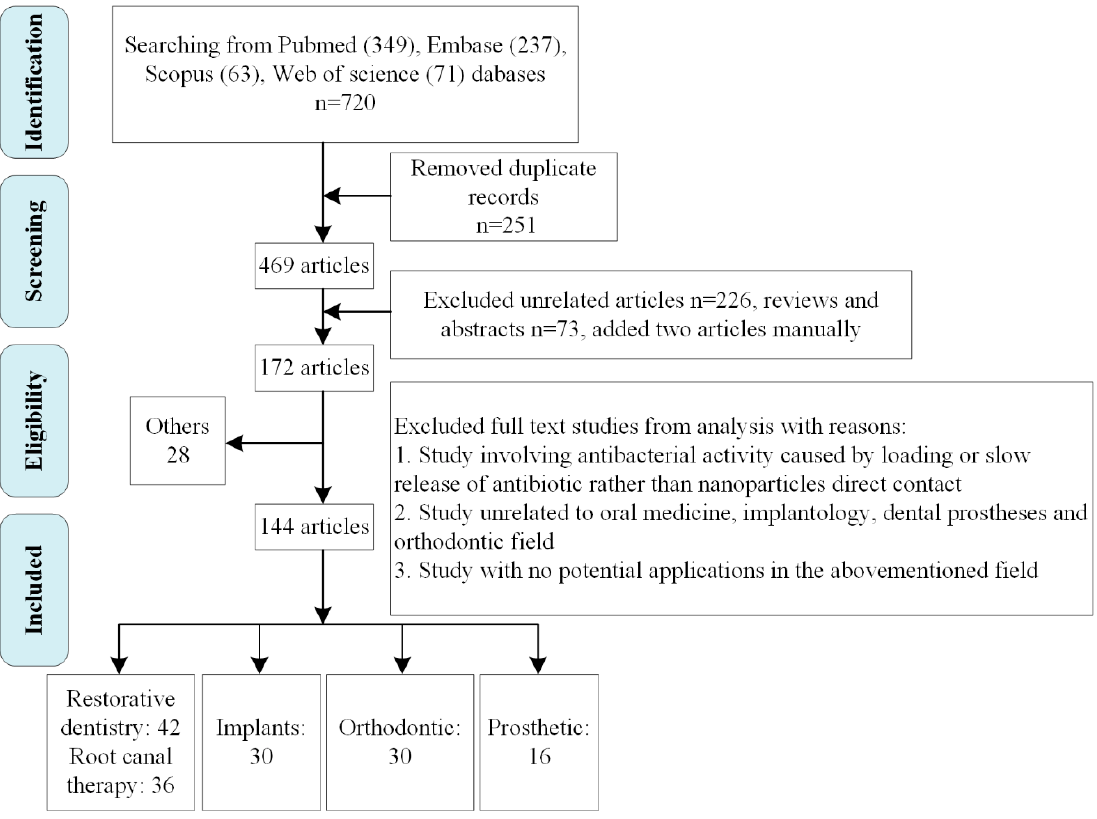
Figure 1. Inclusion/exclusion criteria and study flow for the systematic review.